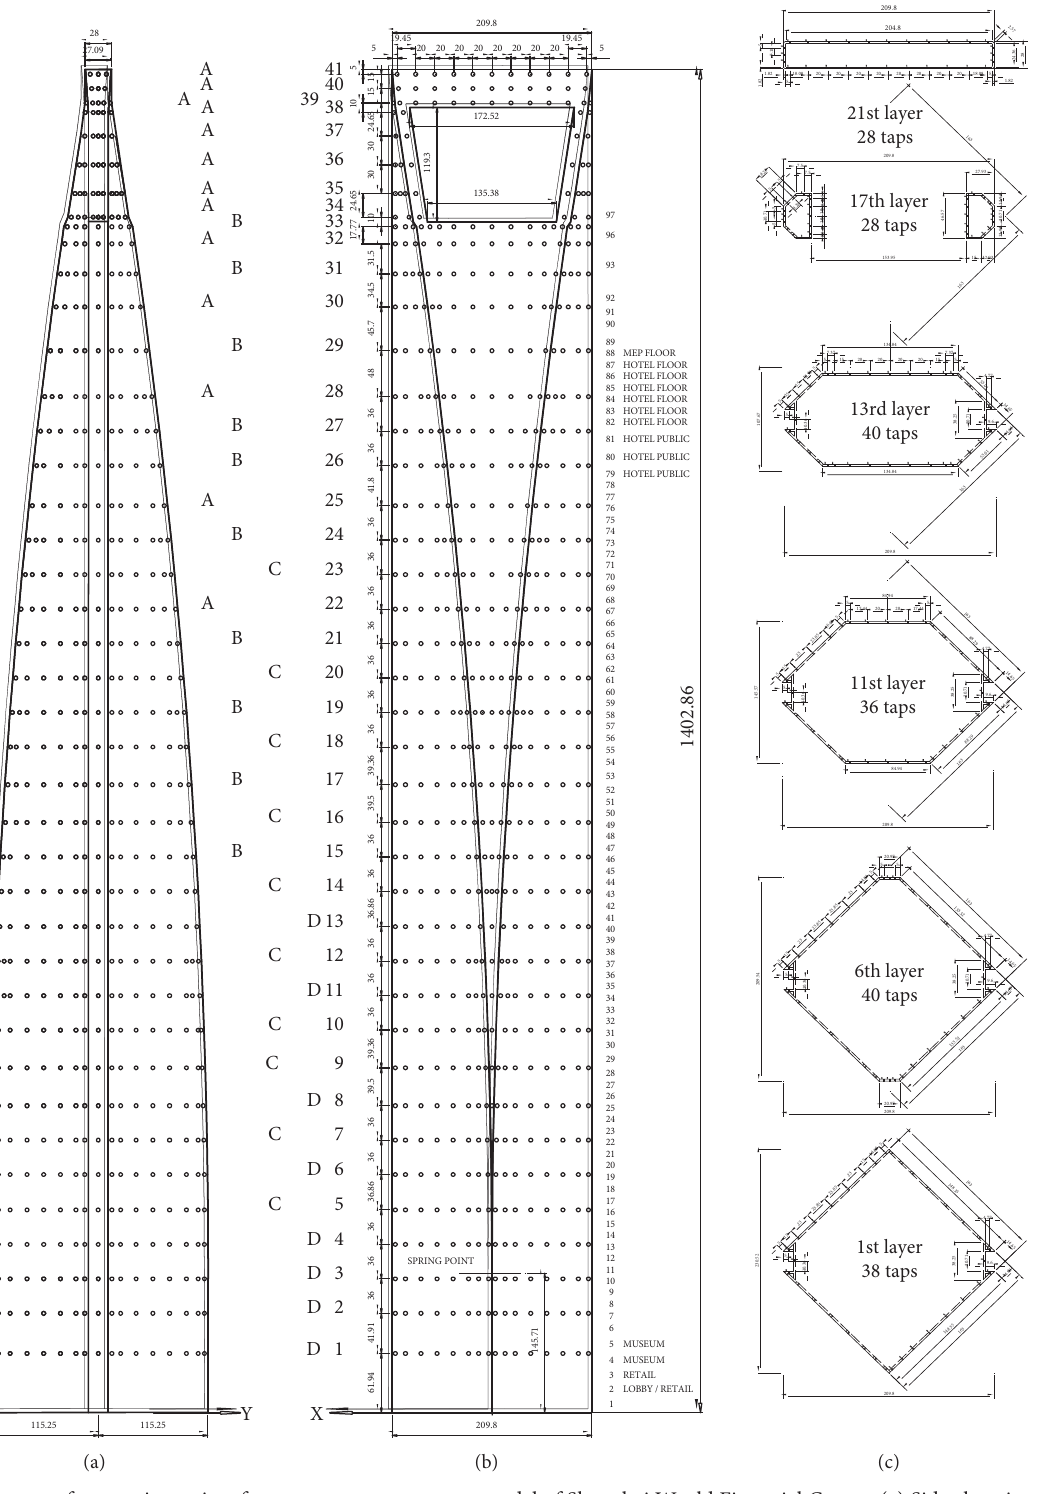
Figure 11: Layout of measuring points for pressure measurement model of Shanghai World Financial Center. (a) Side elevation. (b) Front elevation. (c) Cross section on typical According to Figure 10(b), the wind load values of the measuring points deployed at 16 th , 18 th , and 20 th floors are negative, and they are shown in Table 5. The results show